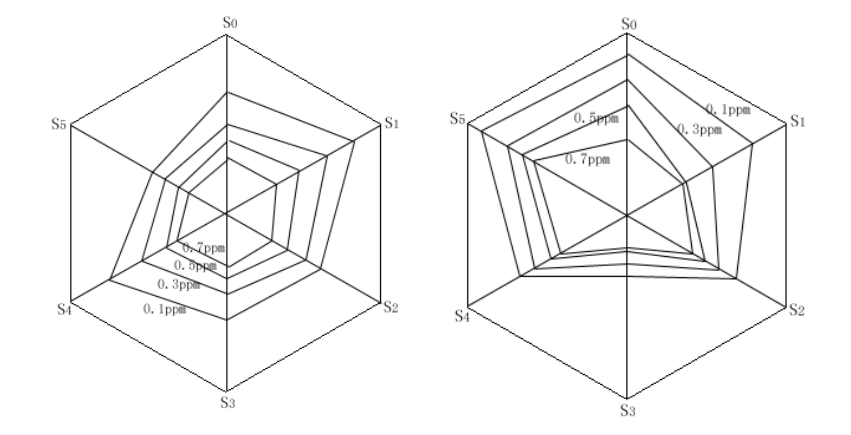
Figure 9. Polar plots of acephate and trichlorphon gas under different concentration (left: acephate, right: